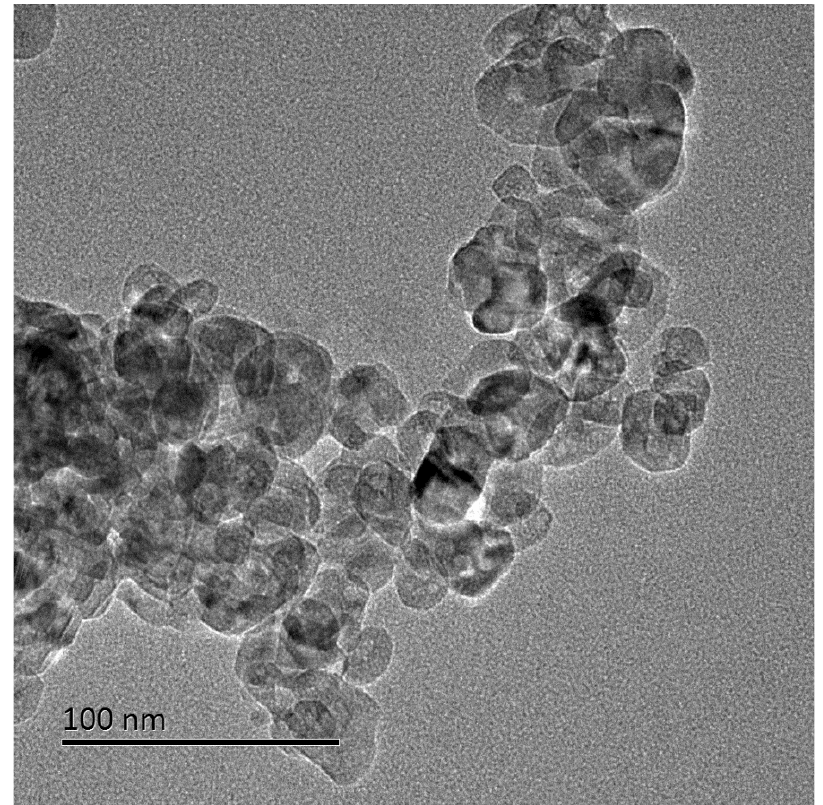
Figure 1. Transmission electron microscopy (TEM) image of TiO 2 NPs.